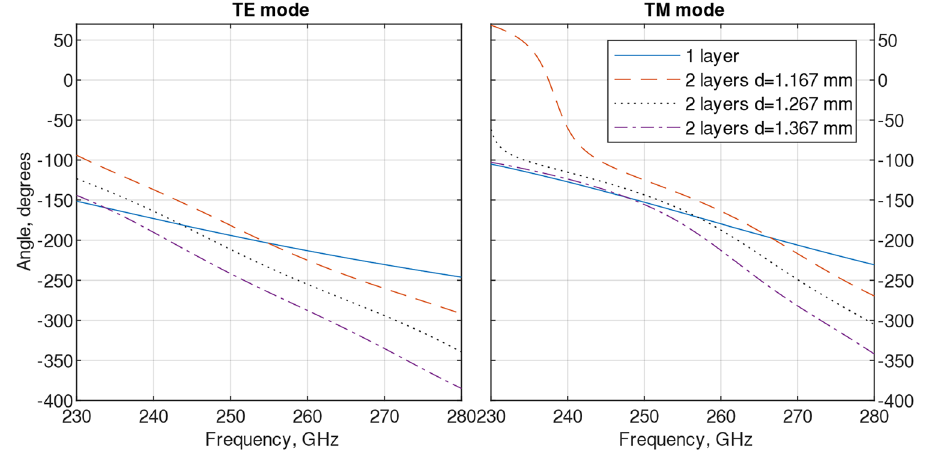
Figure 4. Simulated phase for both TE and TM polarizations.